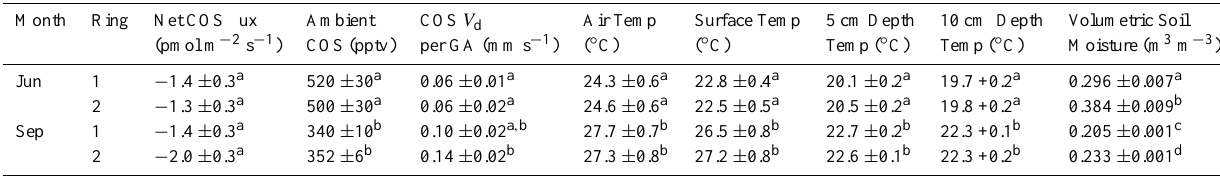
Table 2. Means ± standard error ( n ≥ 7)for the soil static chamber measurements made in June and September 2005. Mean fluxes and deposition velocities, V d , are normalized to ground area (GA). Superscripts a, b, c, and d indicate significantly different means within each column ( p < 0 . 05, independent means t-test, SPSS v.